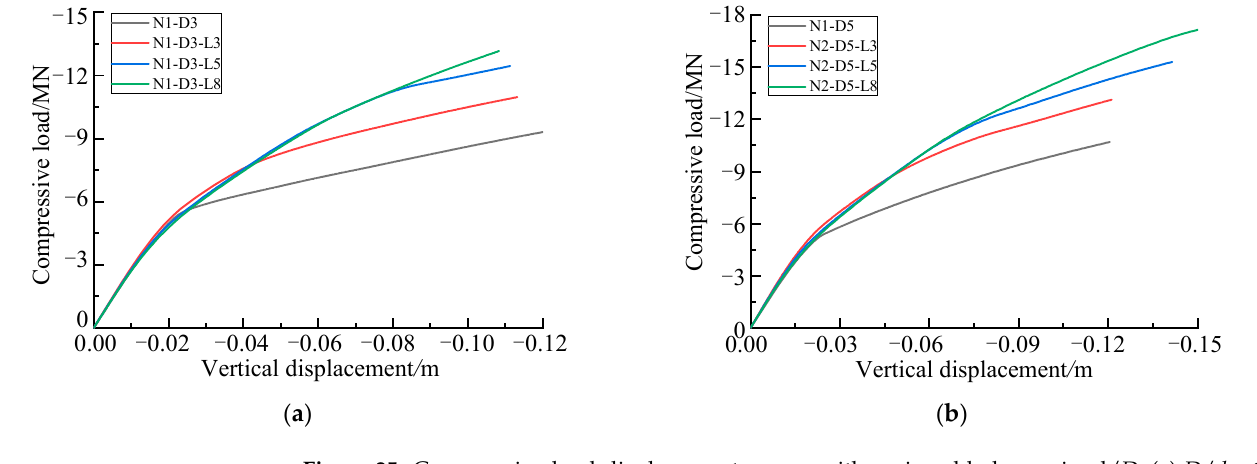
Figure 25. Compressive load-displacement curves with various blade spacing l/ D . ( a ) D / d = 1.5, n = 2; ( b ) D / d = 2.5, n = 2. Table 7. Compression efficiency coefficient with various blade spacing l/ D .